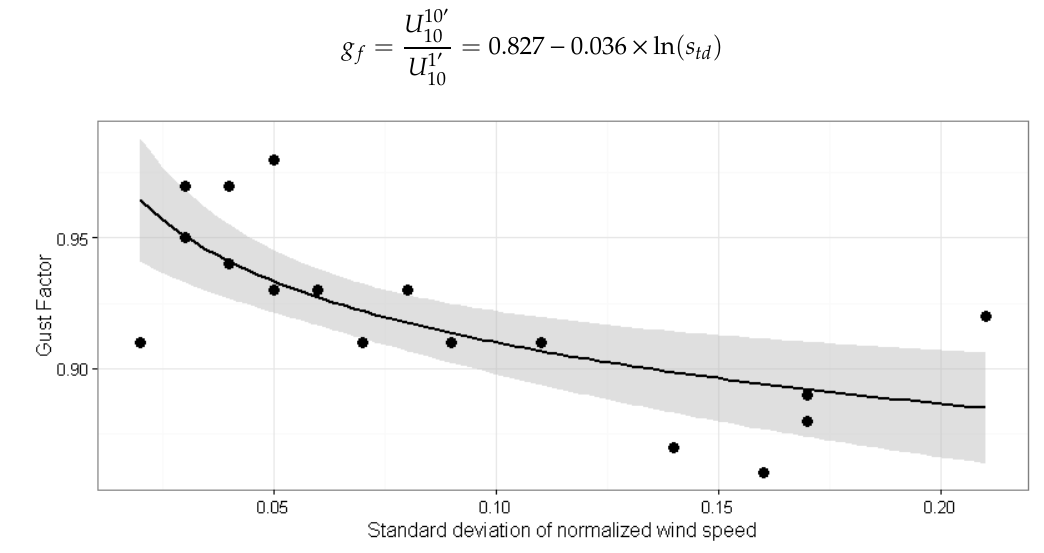
Figure 2. Fitted curve of the gust factor and the manually adjusted gust factors.